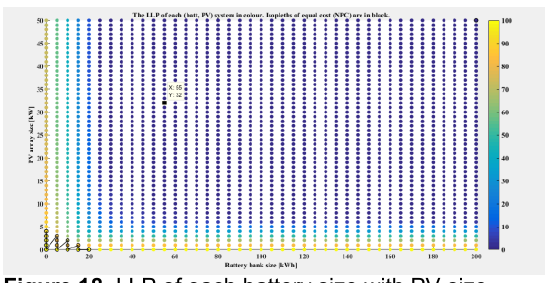
Figure 18. LLP of each battery size with PV size